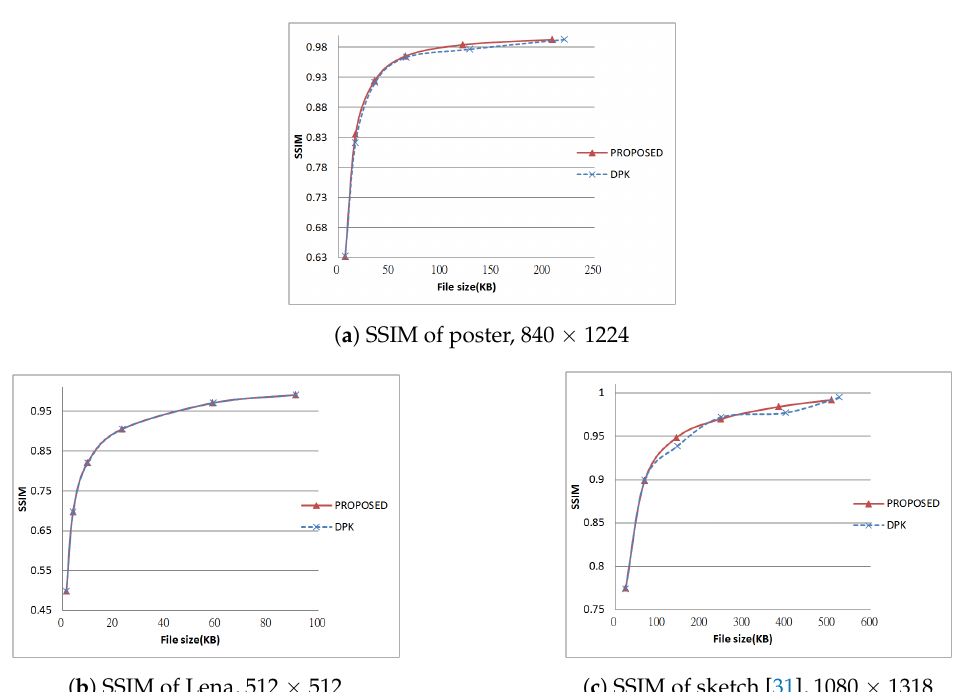
Figure 31. SSIM of test results, Part